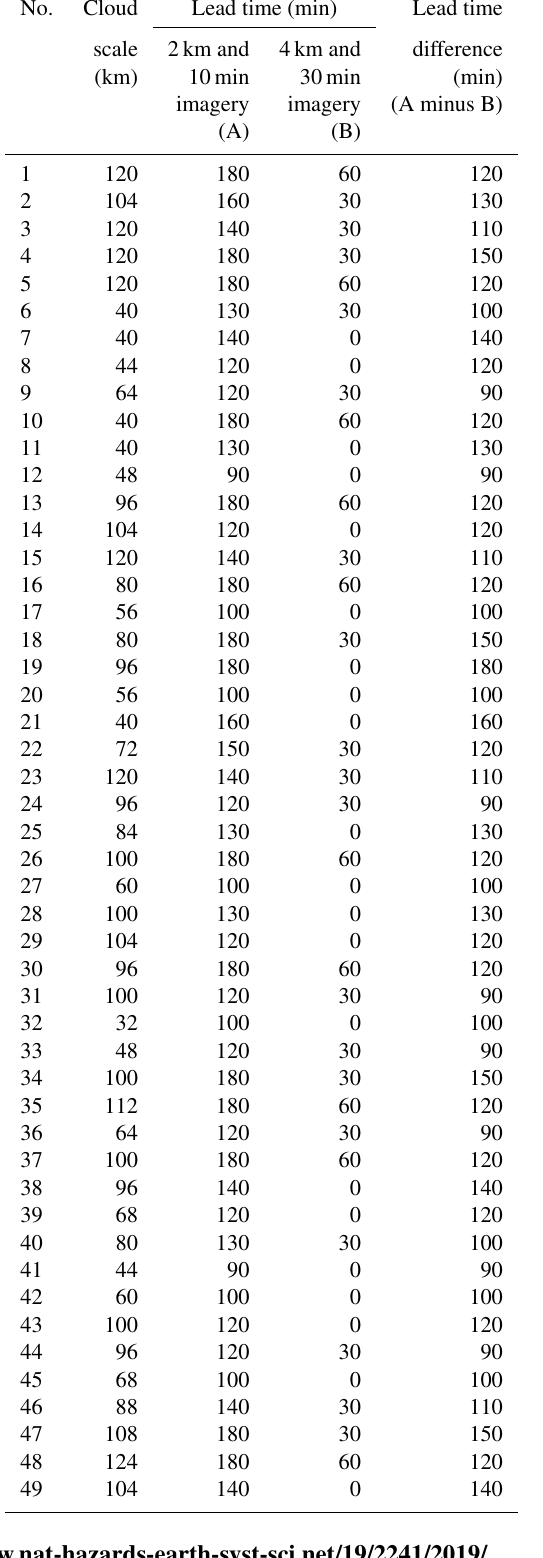
Table 3. The lead time of the clouds according to imagery oc- curred in the daytime of July 2017 for nos. 1–20, in the nighttime of July 2017 for nos. 21–30, in the daytime of August 2017 for nos. 31–50, and in the nighttime of August 2017 for nos.